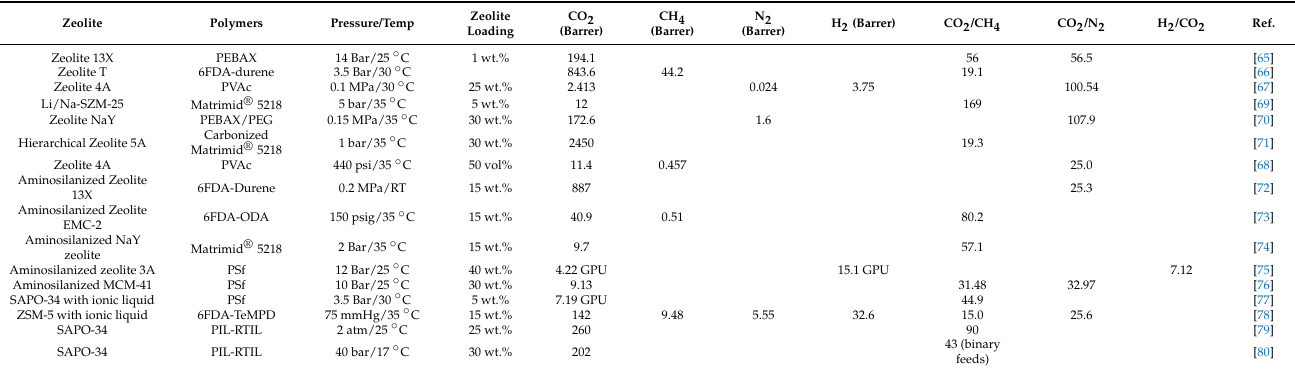
Table 1. Transport properties of zeolite/polymer mixed matrix